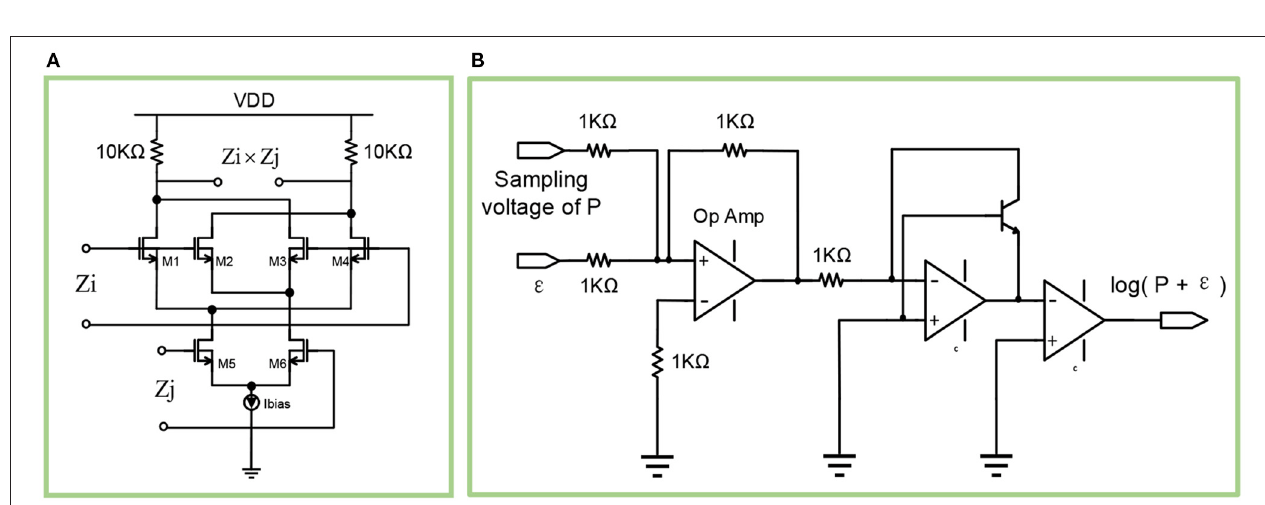
FIGURE 8 | (A) The diagram of the multiplication circuit. (B) The diagram of the logarithmic circuit. Z trace as an example) and the curves of the resistances of two physical memristor devices are depicted in Figure 4